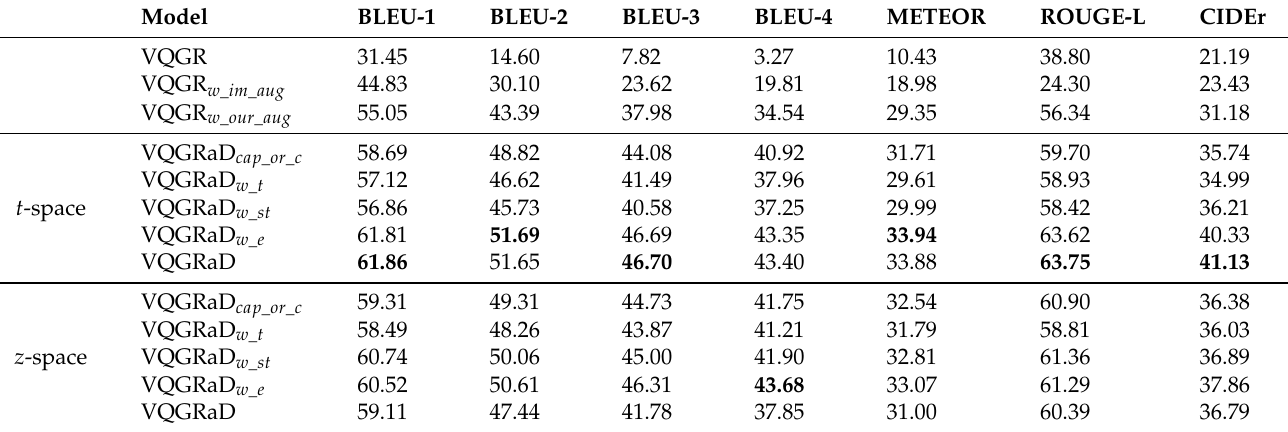
Table 2. Ablation study and comparison of VQGR (baseline) and VQGRaD